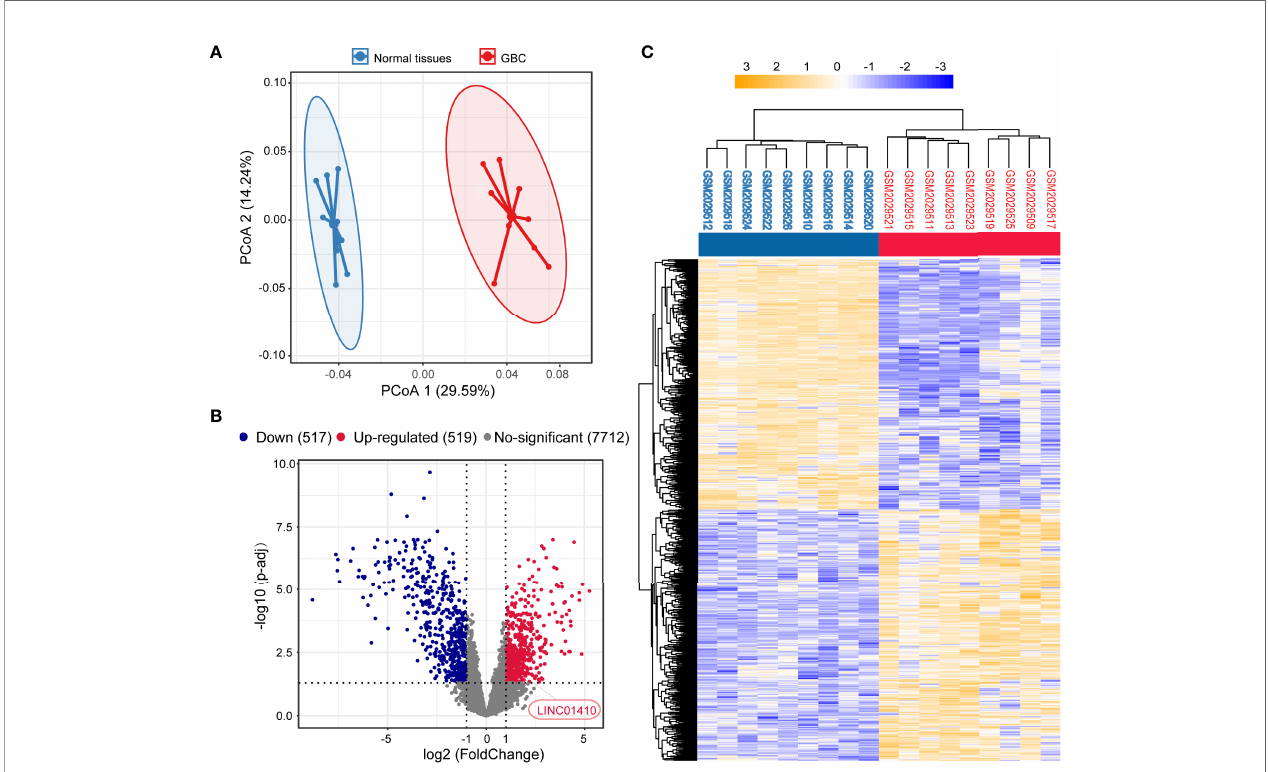
FIGURE 1 | Identi fi cation of differentially expressed lncRNAs between the GBC and matched non-tumor samples. (A) Principal component analysis (PCA) of the lncRNA expression pro fi les in each sample. (B) Volcano plot of the differentially expressed lncRNAs. (C) Two-dimensional diagram of differential expressions of 1,036 lncRNAs, and the data were organized by transcript and tumor and non-tumor category based on